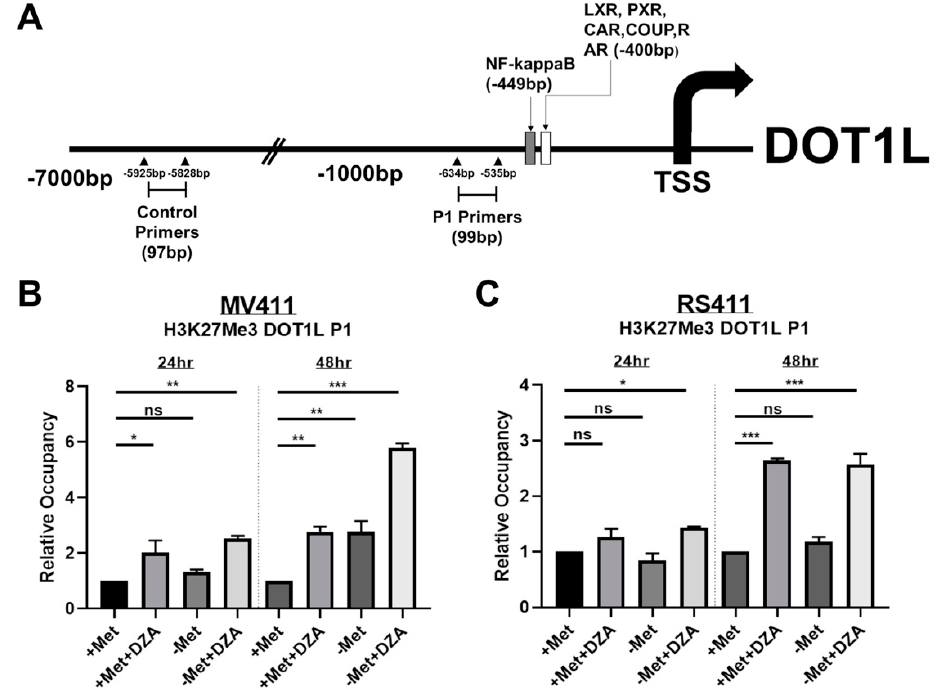
Figure 4. Decreased expression of DOT1L is correlated to changes in histone methylation dynamics specifically at the DOT1L promoter. ( A ) DOT1L promoter map illustrating putative transcription factor binding sites as determined by MotifMap software, as well as the specific binding sites of the DOT1L promoter specific primers (P1) and the distal control primers. ( B ) MV411 cells show significantly elevated levels of H3K27me3 occupancy at the DOT1L promoter following DZA treatment or methionine deprivation and by 48 h an additive increase was observed under simultaneous methionine deprivation and DZA-mediated SAHH inhibition (Tukey HSD, * = p < 0.05 ** = p < 0.01 *** = p < 0.001). ( C ) RS411 cells exhibit significantly increased DOT1L promoter H3K27me3 occupancy following 24 h of simultaneous methionine deprivation and DZA exposure, and by 48 h, DZA treatment alone but not methionine deprivation alone is su ffi cient to significantly elevate DOT1L-promoter H3K27me3 occupancy (Tukey HSD, * = p < 0.05 *** = p <